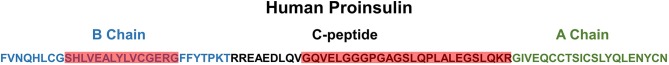
Amino acid sequence of human proinsulin with shaded areas representing CD4 T cell epitopes recognized by islet derived T cells. T cells obtained from the insulitis lesions of recent onset T1D organ donors respond to epitopes within the shaded area of the insulin B chain, the B:9-23 region, and C-peptide including the amino acid sequence GQVELGGG which forms a portion of hybrid insulin peptides. These islet derived T cells are predominantly activated by peptides presented by HLA-DQ8.